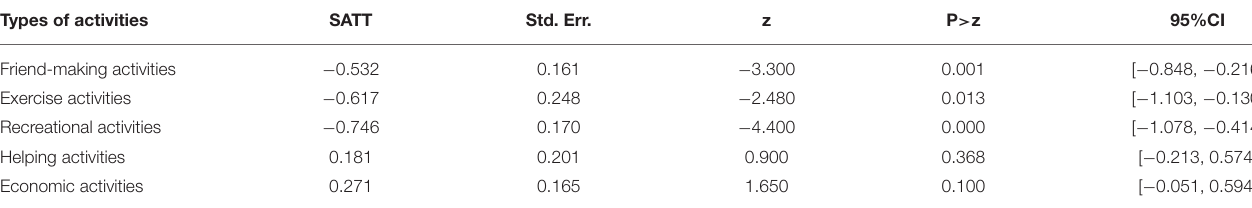
TABLE 7 | Sample average treatment effect for the treated using the bias-corrected estimator estimates. Types of activities